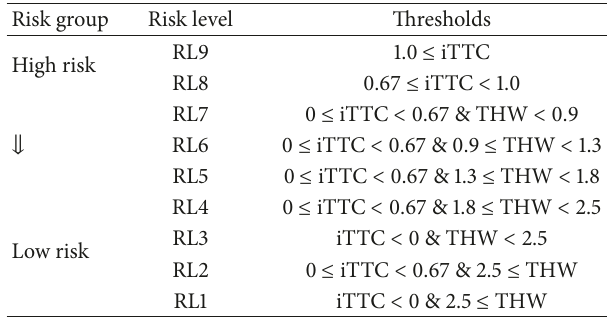
Table 2: Instantaneous driving risk level